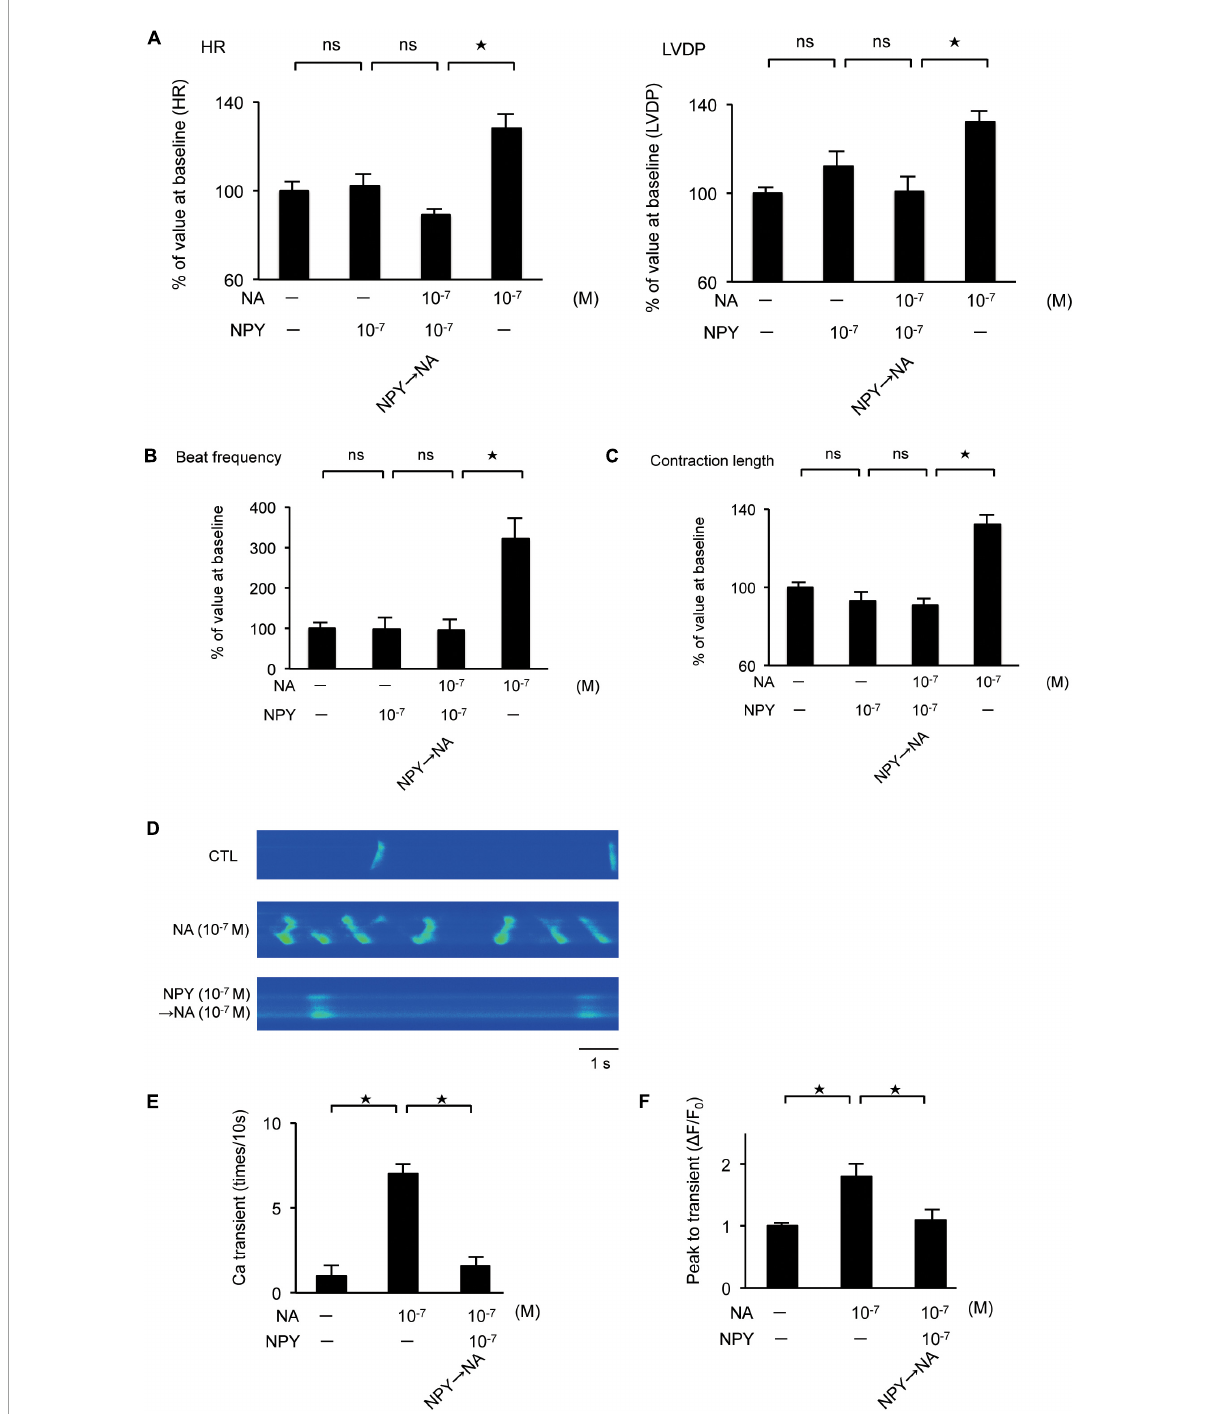
FIGURE4 (A) Investigation of the effects of neuropeptide Y (NPY) on left ventricle (LV) contraction using the Langendorff procedure. Pretreatment with NPY completely blocked NA-induced increase in heart rate and LV developed pressure ( n = 4 for each group). (B,C) The measurement of beat frequency and contraction length using primary cultured cardiomyocytes revealed that when hearts were exposed noradrenaline (NA), beat frequency and contraction length significantly increased ( n = 4). Conversely, when hearts were first exposed NPY, beat frequency and contraction length did not increase after NA administration ( n = 4). (D–F) Effects of NPY on ventricular cardiomyocytes isolated from adult rats based on the measurement of the frequency of Ca 2 + transients and the peak to transients. The frequency of Ca 2 + transients and the peak to transients in isolated ventricular cardiomyocytes increased significantly when cells were exposed to NA only, but increases were not observed when cells were first exposed to NPY and then administered with NA ( n = 4 for each group). * p < 0.05, ns: not